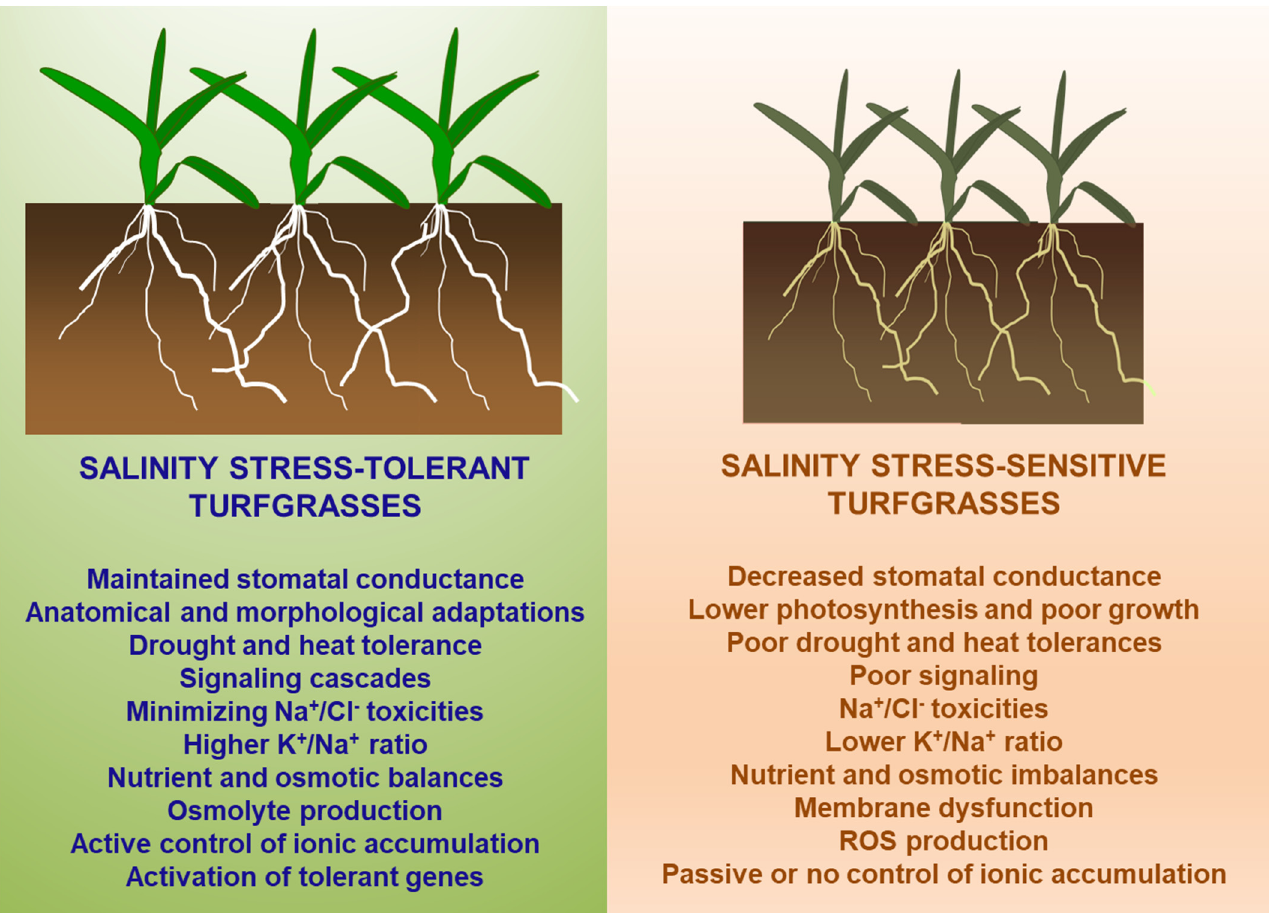
Figure 3. Metabolic processes associated with salinity tolerances and sensitivities among turfgrass species and cultivars.